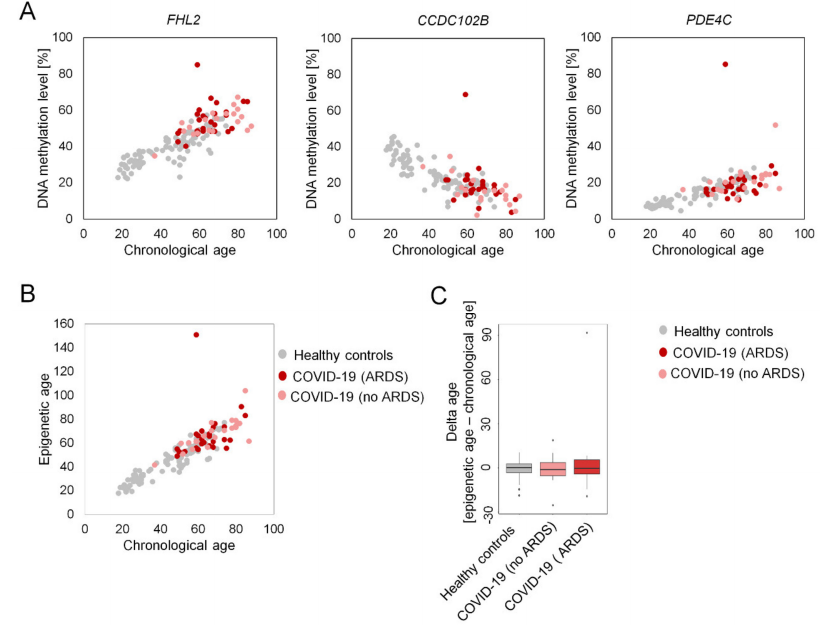
Figure 2. Epigenetic age predictions with amplicon sequencing. ( A ) DNA methylation levels at the 3 age-associated CpG sites correlate with donor age. Samples of 47 COVID-19 patients with ( n = 27, red) or without ARDS ( n = 20, light red) do not show an offset in the DNA methylation levels in comparison to 95 healthy control samples (grey), except for one outlier. ( B ) Based on these DNA methylation levels the epigenetic age was predicted with a multivariable model. ( C ) The deviation of chronological and predicted epigenetic age (delta-age) is presented (no significant differences; Welch’s t